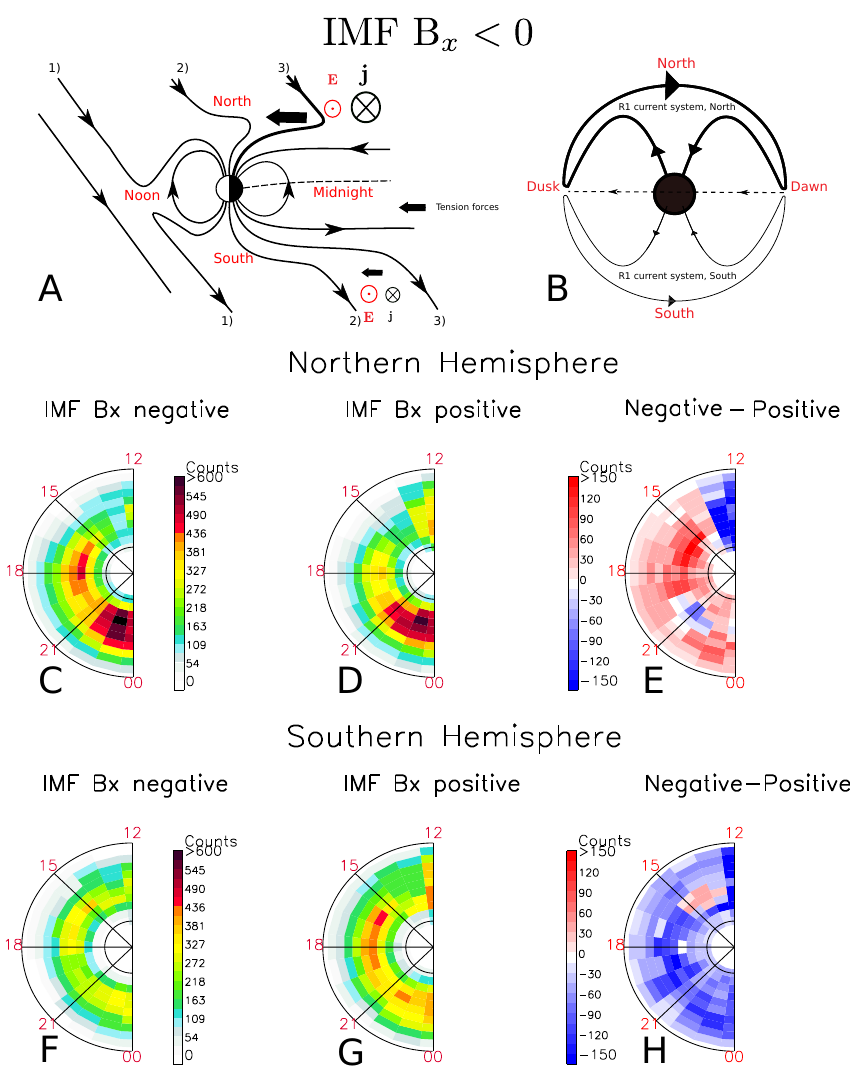
Figure 11. (a) Due to a negative IMF B x (and B z < 0) the magnetic tension force on open field lines (2 and 3) is larger in the Northern Hemisphere (large black arrows) than in the Southern Hemisphere (Cowley, 1981). (b) Associated current systems. ( c and f ) Northern and Southern Hemisphere for IMF B x negative. ( d and g ) Northern and Southern Hemisphere for IMF B x positive. (e) The difference between (c) and (d) . (h) The difference between (f) and (g) . Panels (c–e) are similar to Fig. 2 (a–c) , and panels (f–h) are similar to Fig. 3 (a–c) in Reistad et al.